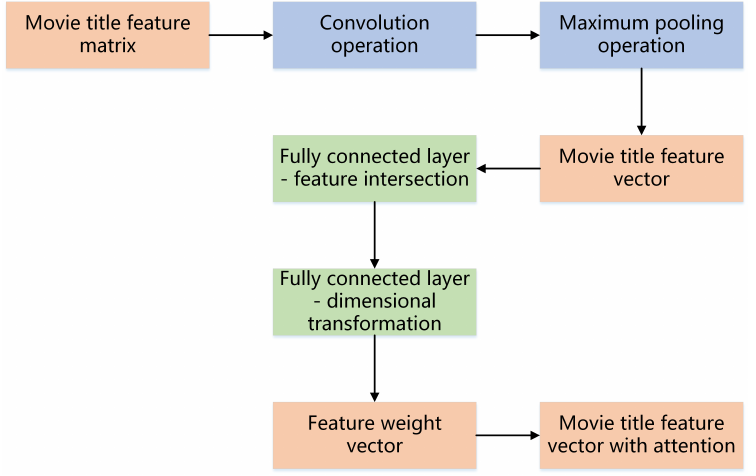
Figure 9. Movie title feature processing